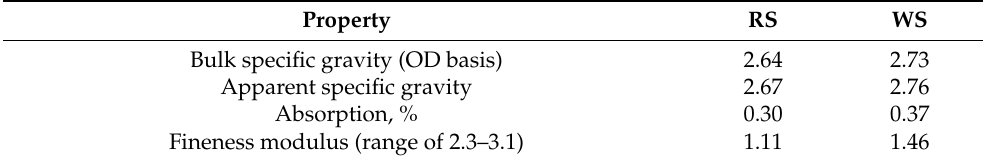
Figure 1. Grain size distribution of ( a ) types of cement and ( b ) aggregates. Table 2. Physical properties of RS and Table 1. Physicochemical properties of PC and SCMs.